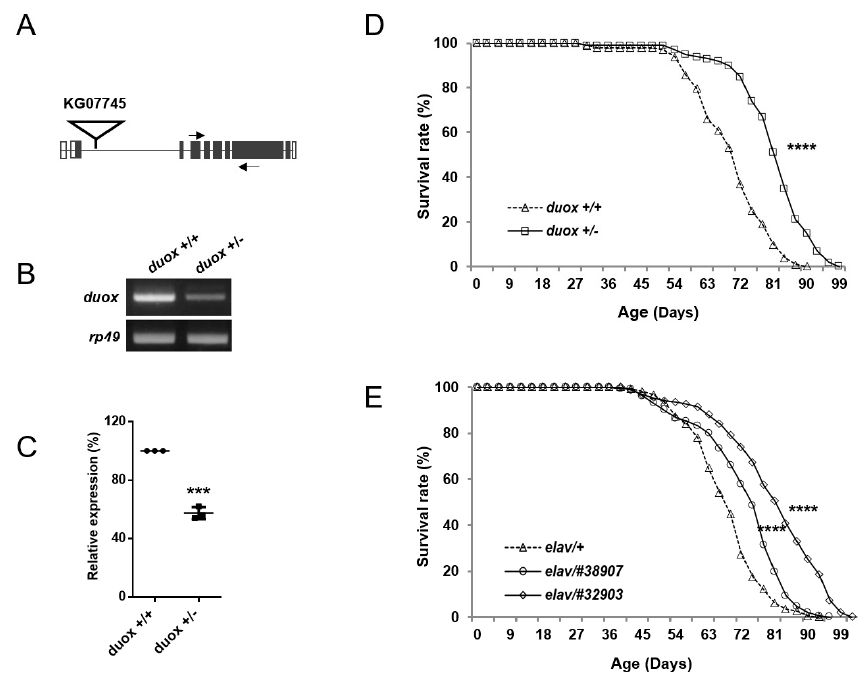
Figure 1. Extension of male lifespan with duox heterozygosity and neuronal duox knockdown. ( A ) Diagram showing the location of the P-element (KG07745), which is inserted in the second intron of duox . Empty and filled squares denote noncoding and coding regions of exons, respectively. Arrows denote primers used for RT-PCR. ( B ) Agarose-gel image of RT-PCR products following amplification of the duox gene from control ( w 1118 , denoted duox +/+ ) and heterozygous ( duox KG07745/+ , denoted duox +/ − ) flies. rp49 was used as a loading control. Three independent experiments carried out with similar results. ( C ) qRT-PCR of duox gene, with rp-49 used as a control. Relative expression denotes duox transcript level. Averages and standard errors were derived from three independent experi- ments. Student’s t -test, *** p < 0.001. ( D ) Lifespan of wild-type and duox heterozygous male flies.